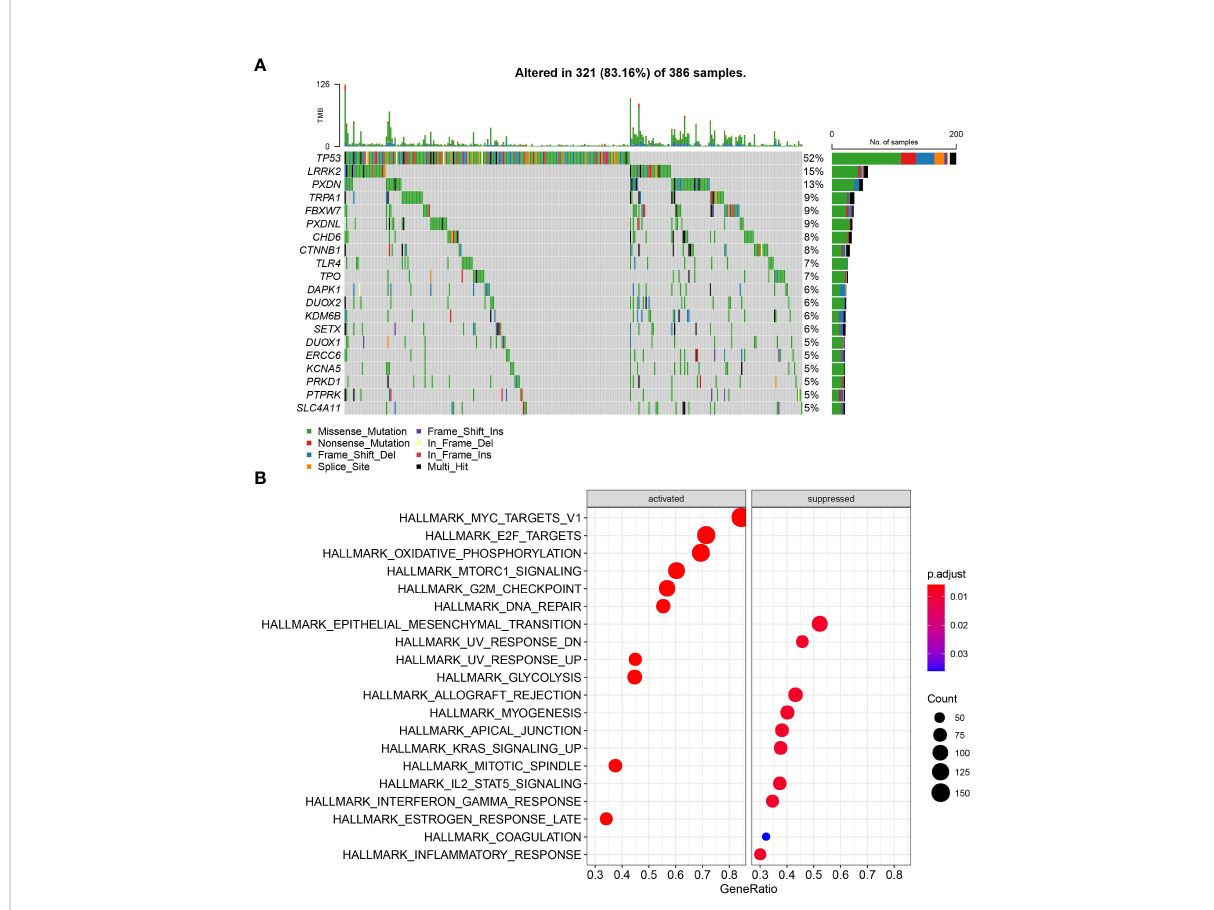
FIGURE 1 The mutation patterns and transcriptome characteristics of OSRGs in STAD. (A) Mutation pro fi le of OSRGs in patients with STAD; (B) GSVA analysis between the mutant group and the WT